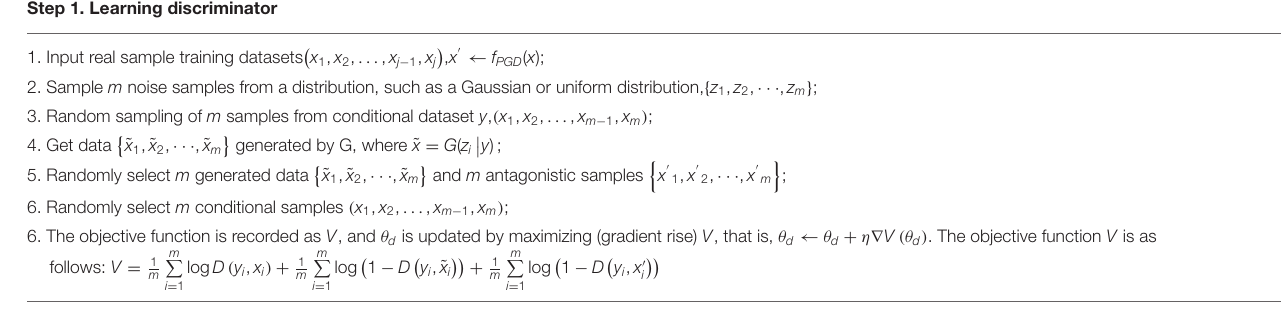
TABLE 1 | Algorithm of learning discriminator.